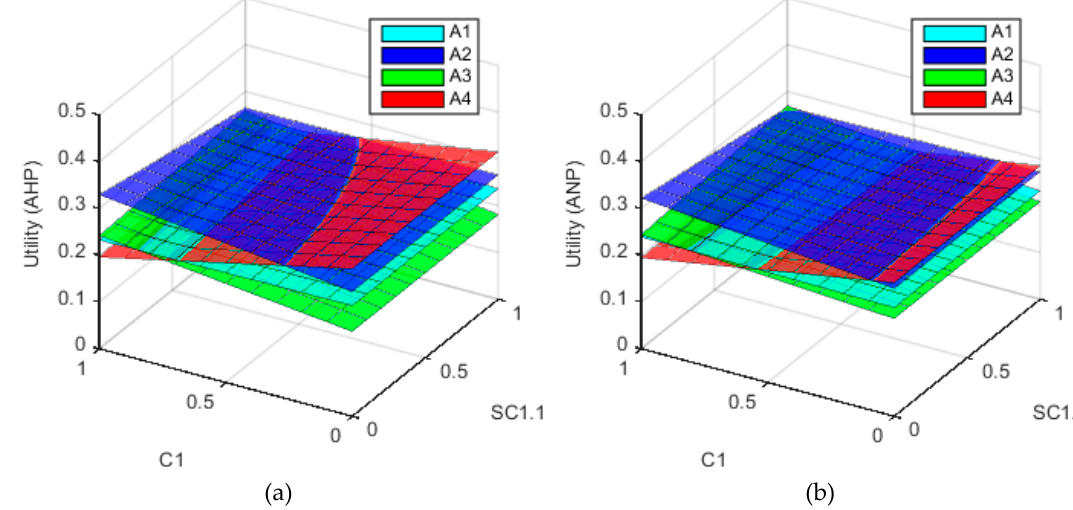
Figure 4. Utility of alternatives determined by means of: (a) the AHP method; (b) the ANP method; depending on the weight of the criterion C1 and sub-criterion C1.1.